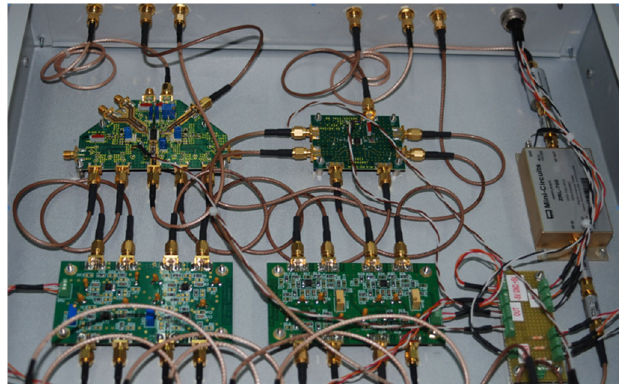
FIG. 1. Picture of the interior of the analog front end for rf-baseband and baseband-rf conversion; the upper left board is the IQ